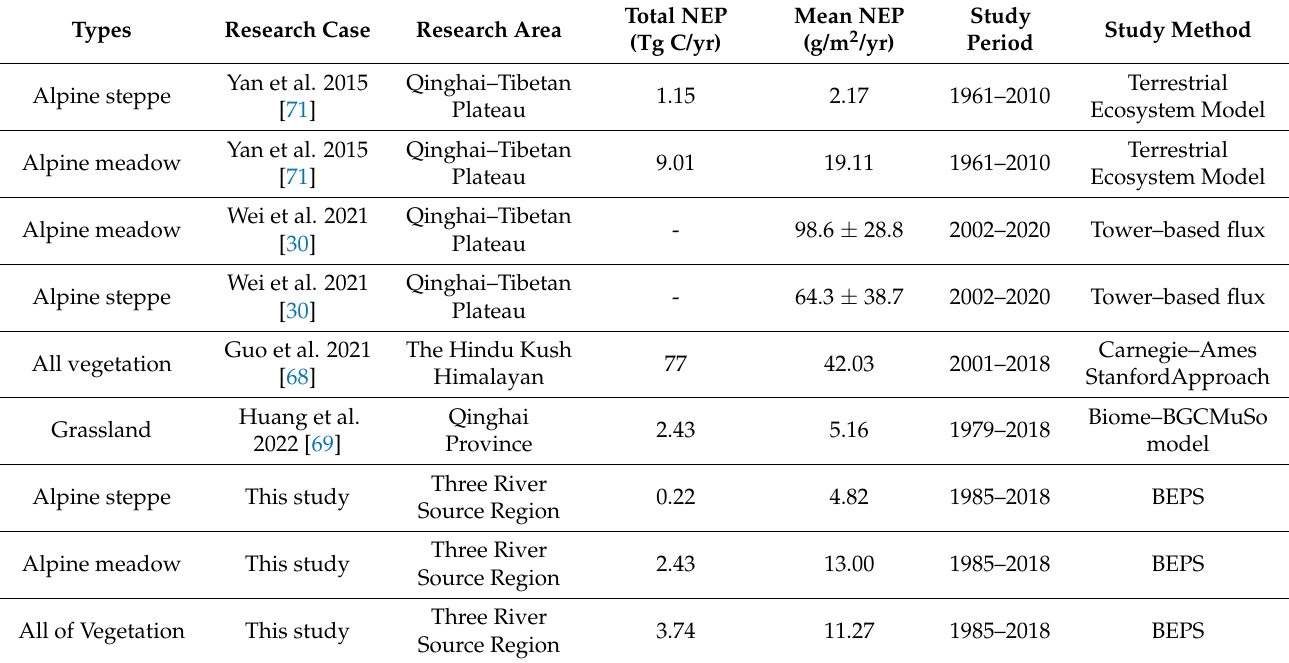
Table 5. Comparison with other NEP estimation